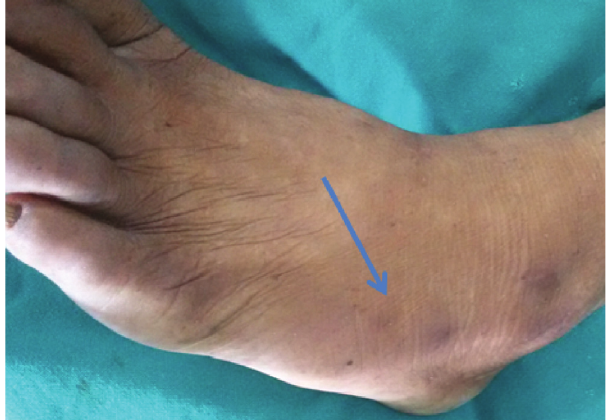
Figure 3. Intraoperative dural compression and wasting seen in a case of canal